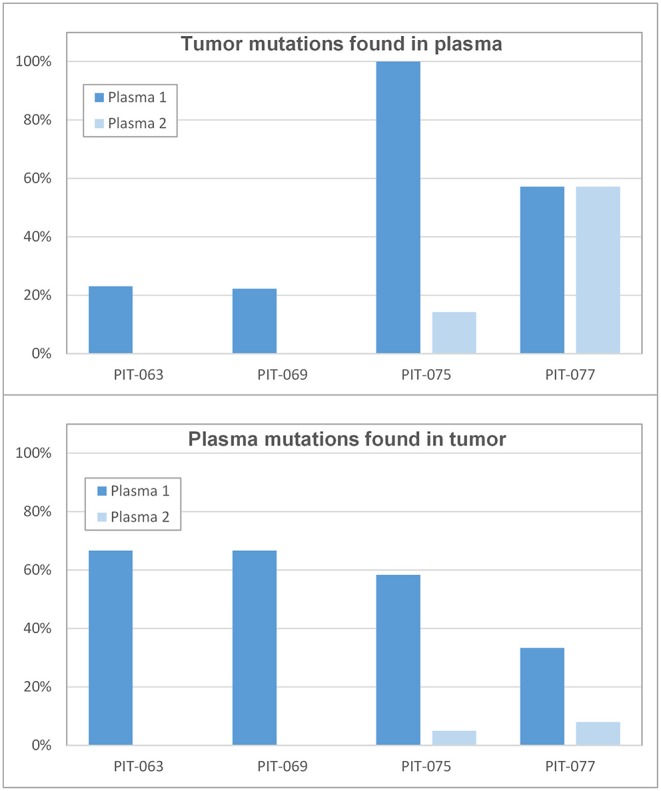
Correlation between tumor and plasma samples (Top) percent of tumor mutations that were found in the first (time 0) and second (3 months) plasma samples. (Bottom) percent of plasmatic mutations that existed in the original tumor.